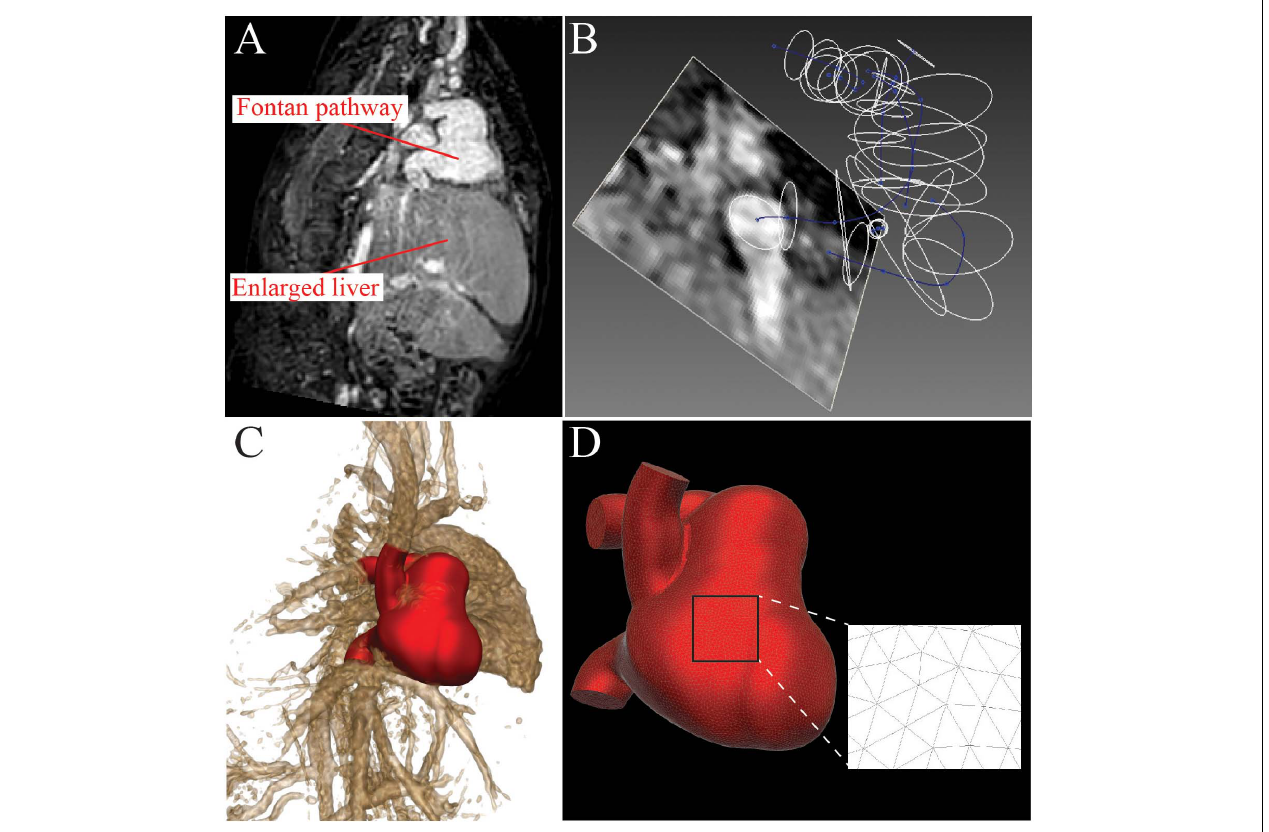
FIGURE 2 | A patient-specific model of the Fontan pathway was constructed from 3D mDIXON MRI data using the CRIMSON software. (A) 3D mDIXON MRI data shows a dilated Fontan pathway and enlarged liver. (B) 3D path lines were created and 2D contours were made to delineate the vessel walls. (C) Vessel contours were combined with a lofting and blending process to create the 3D anatomical model. (D) The 3D anatomical model was discretized to create a finite-element mesh consisting of tetrahedral